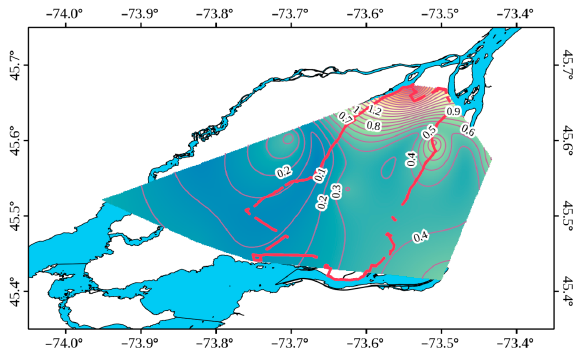
Fig. 6. The test trajectory for validating the results. Contour lines show the magnitude of correction in